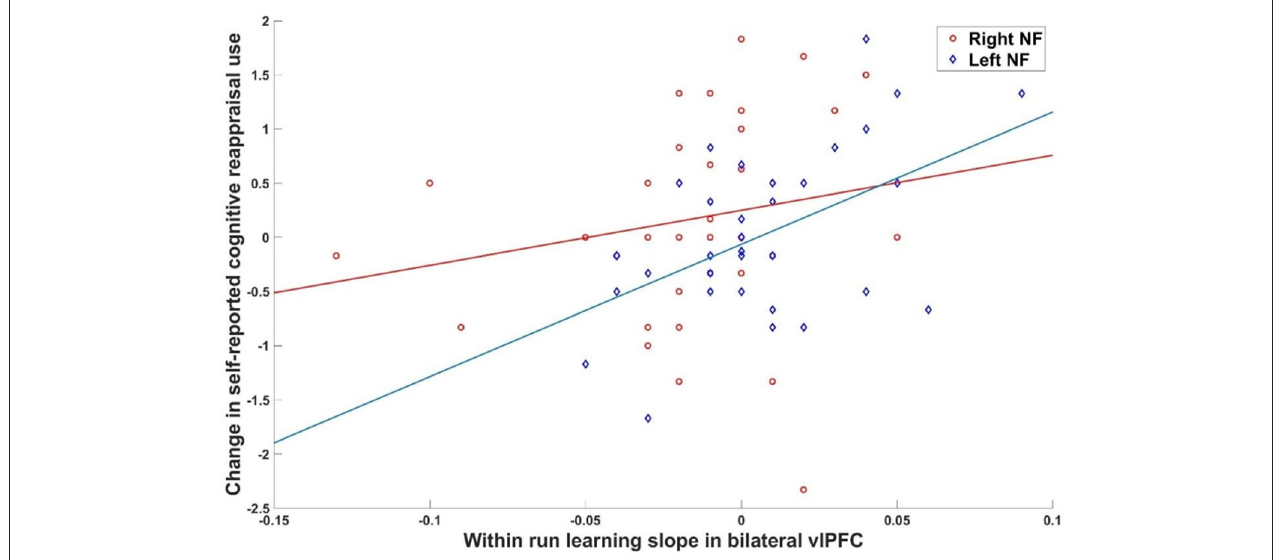
FIGURE 2 | Brain behavior relationship. Association between within run learning during the first NF day and change in cognitive reappraisal use was significant for left ( r = 0.484, p = 0.002) but not right ( r = 0.170, p = 0.150) vlPFC feedback.